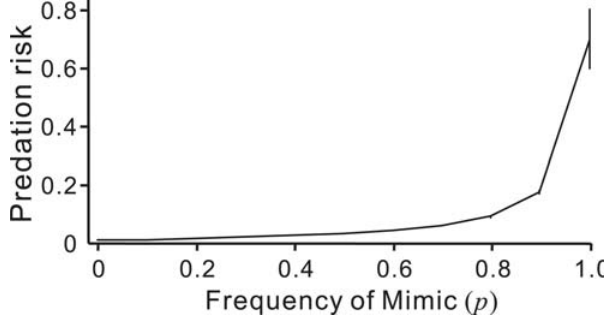
Figure 5. The result of a density multiplying simulation. The densities of the Mimic and the Model vary between 0 and 0.5 while their ratio remains constant (1:1). Each point and error bar represent the mean and standard deviation of the replications. Red line and green line denote the mean percentage of prey and the mean number of prey being attacked, respectively. X mo =0.2, X mi =0.8, T =0.8, a =0.5, Q =0.02. Increasing the density of the Model, the percentage of the prey attacked decreases while the number of them increases.